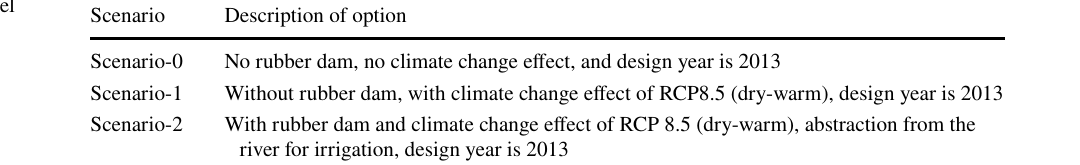
Table 4 Groundwater model